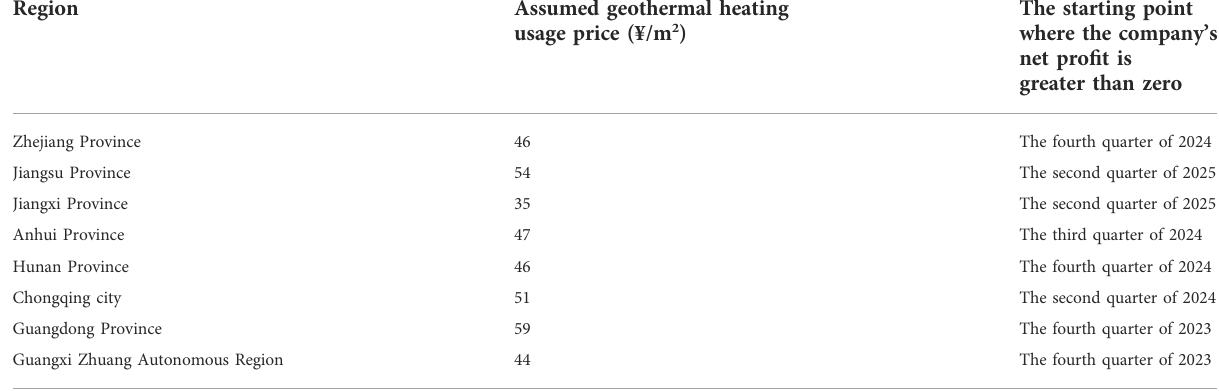
TABLE 8 Collection of geothermal resource taxes in 8 provinces and cities for non-central heating. Region